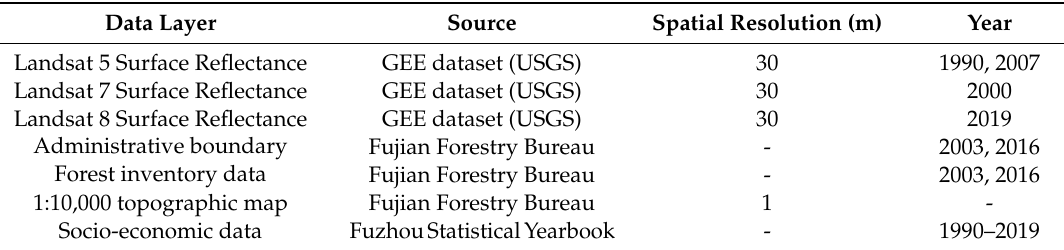
Table 1. Data sources used in this study.